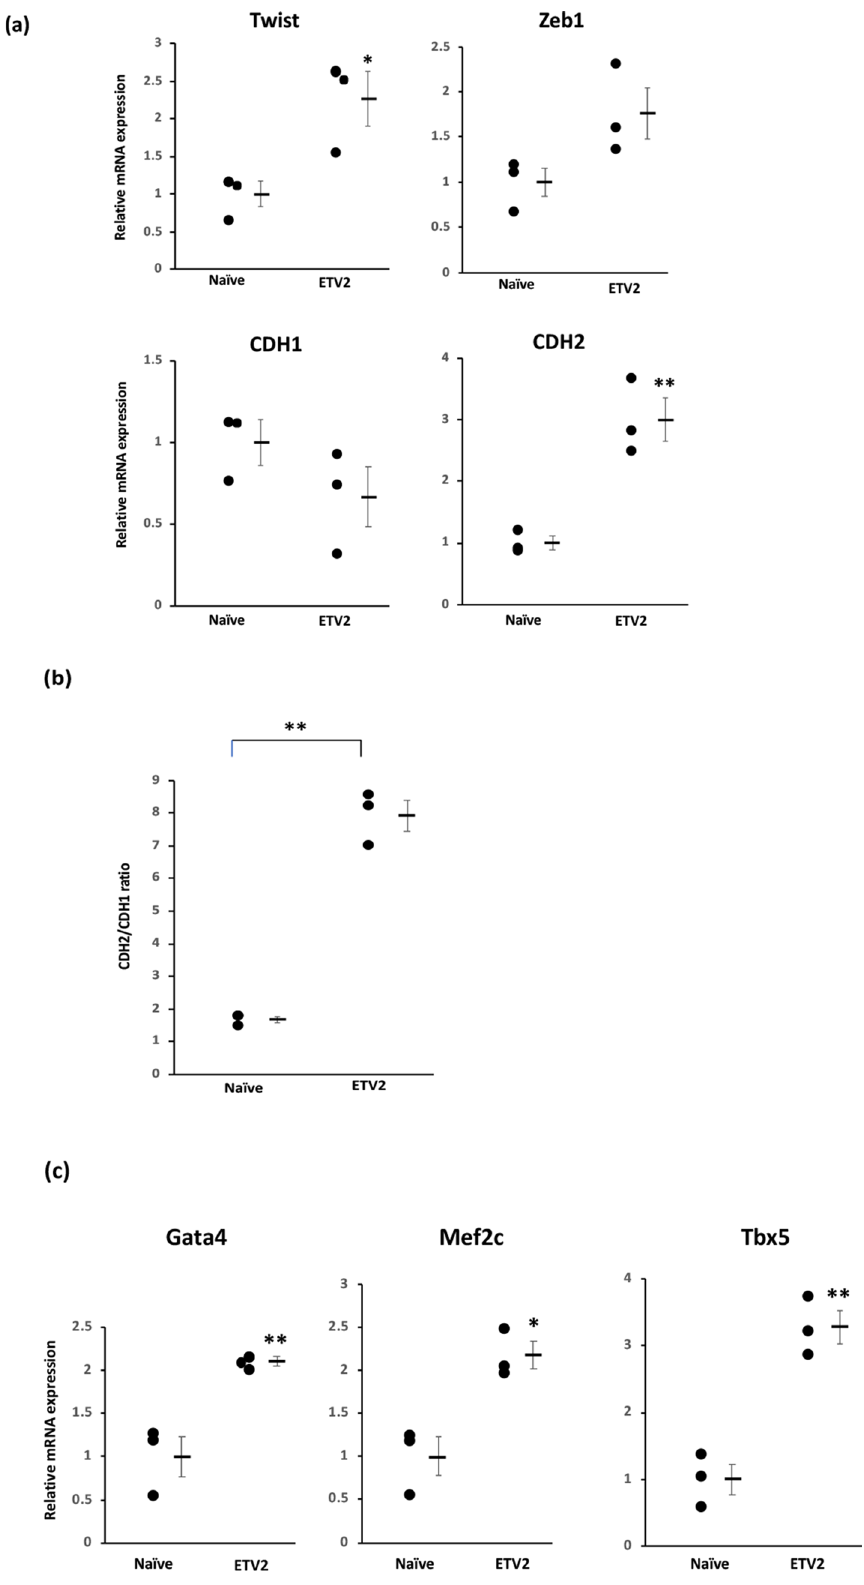
Figure 5. ETV2 treatment induces cell plasticity and cardiogenic marker expression in cardiac fibroblasts. Rat cardiac fibroblasts were treated with doxycycline with or without administration of lentivirus encoding ETV2 and rtTA (n = 3). ( a ) qPCR demonstrating upregulated expression of the endothelial-mesenchymal transition (EndMT) markers Twist (*p < 0.05) and CDH2 (**p < 0.01) in ETV2-treated compared to naïve fibroblasts. ( b ) Quantification of FACS data demonstrating an increased CDH2/ CDH1 ratio reflecting EndMT in cells overexpressing ETV2 (**p < 0.01). ( c ) qPCR demonstrating upregulated expression of cardiogenic markers Gata4, Mef2c and Tbx5 in ETV2-overexpressing compared to naïve fibroblasts (* p < 0.05; ** p <